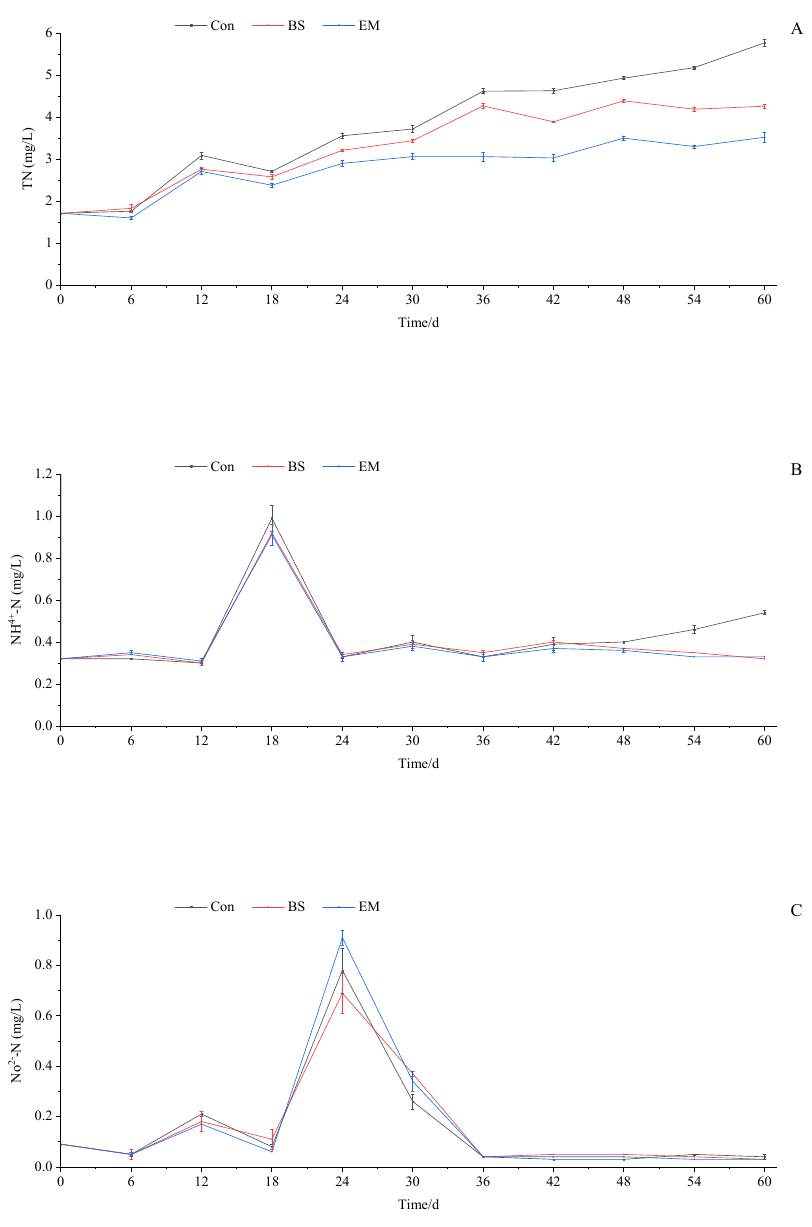
Figure 1. Effect of probiotics on water quality parameters. ( A ) TN, total nitrogen; ( B ) NH 4+ -N, ammonia nitrogen; ( C ) NO 2 − -N, nitrite nitrogen; Error bars are presented as the mean ± standard error ( n =